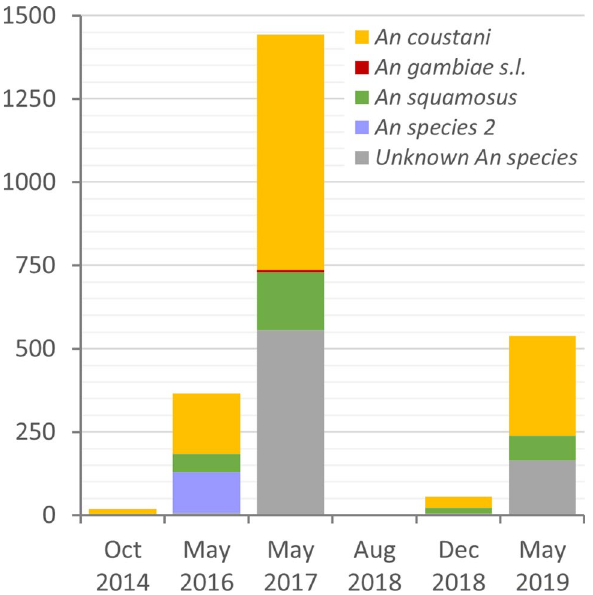
Figure 9. Species composition of adult anophelines trapped in multiple locations in Mongu district, Zambia. Samples collected mainly outdoors using CDC and BG-Sentinel traps, and identified morphologically, with a subset of identities confirmed by sequencing of COI. Data sources: Orba et al. 34 , Wastika et al. 35 , Orba et al. (2021, pers.